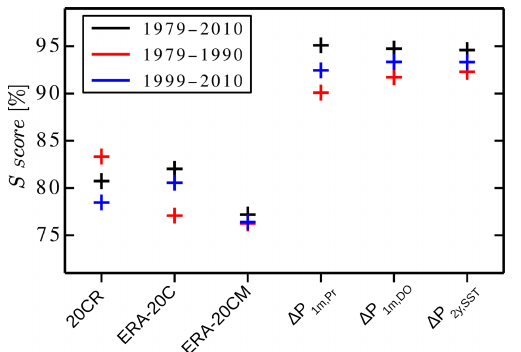
Figure 6. S score computed from the different P simulations against GPCP. The values estimated for the full satellite pe- riod (1979–2010) are presented in black, for the 1979–1990 period are presented in red, and for the 1990–2010 period are presented in blue. For the ERA-20CM dataset, the S score is estimated from the 10-member ensemble